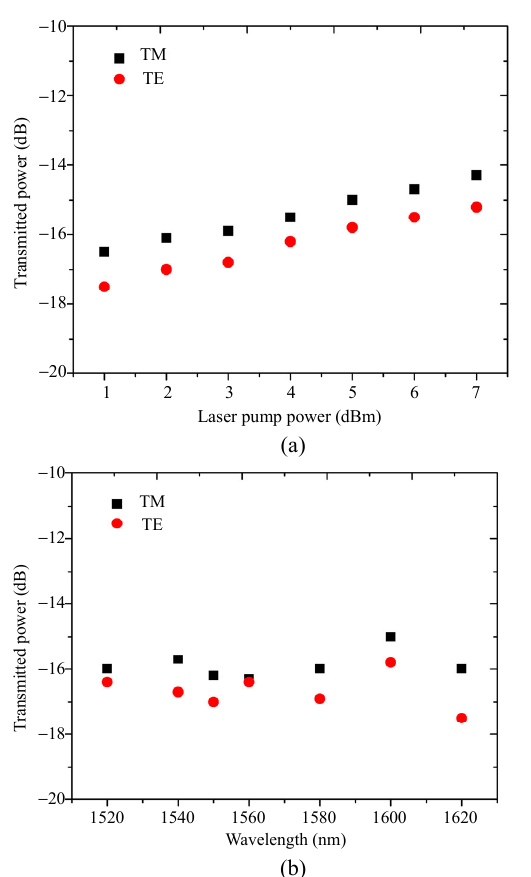
Fig. 8 Response of transmitted power to TE and TM polarizations for different pump powers (a) and wavelengths (b).